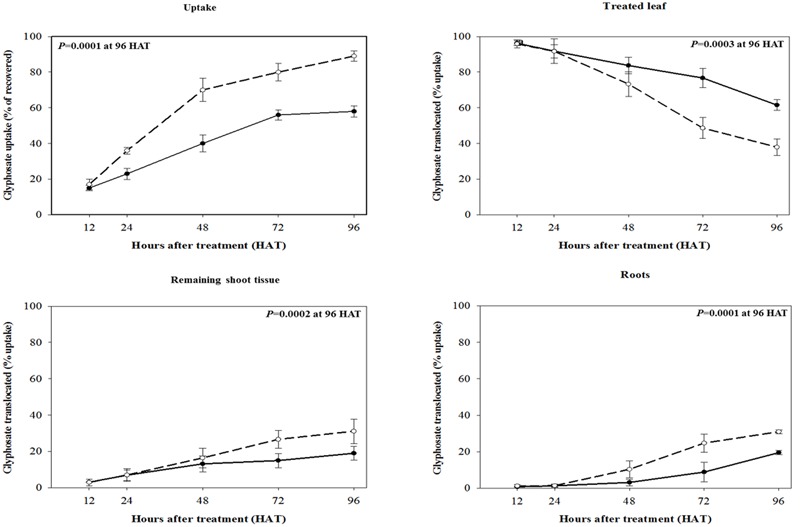
14C-glyphosate foliar uptake and translocation to plant sections in R (•) and S (∘) biotypes of rigid ryegrass at 12, 24, 48, 72, and 96 h after glyphosate application. Symbols denoted mean (n = 5) ± standard errors of the mean.